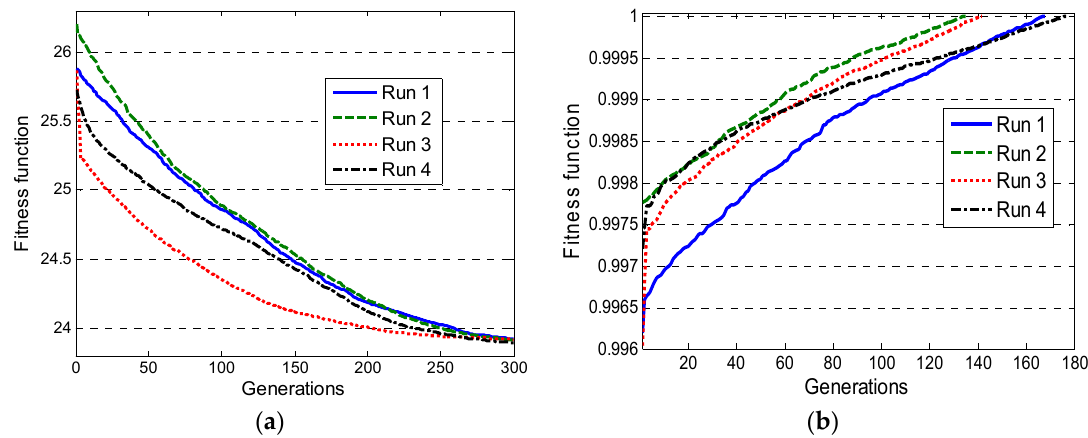
Figure 7. Convergence curves for ( a ) F f 1 and ( b ) F f 2 considering four independent runs (IEEE 57 bus power system).